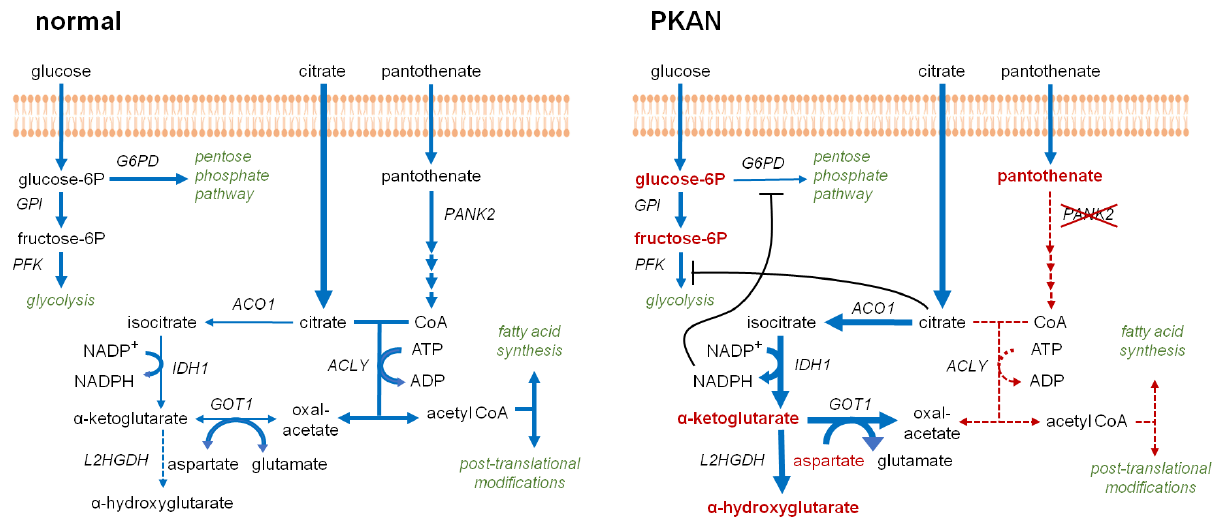
Figure 6. Pathway model of a potential citrate shunt in PKAN erythrocytes. In erythrocytes, citrate imported from the plasma is the only source for the acetyl moiety in acetyl-CoA, which is the primary building block for fatty acid synthesis and essential for post-translational modifications. Its formation is mediated by ACLY under consumption of ATP and citrate. Depletion of CoA largely impairs this reaction in PKAN erythrocytes. An alternative citrate pathway via ACO1 and IDH1 is preferably active in PKAN erythrocytes since metabolites of this route were found to be altered accordingly. Metabolites with normal abundances are in black, pathways are in italic green font. Altered metabolites are shown in red, normal font indicates decreased and bold fonts increased levels. Pathways that are strongly affected in PKAN erythrocytes are indicated with dotted lines and arrow heads in red. The red cross indicates absent/inactive PANK2 protein due to the genetic condition. Black arcs indicate potential inhibition of G6PD by elevated NADPH/NADP + ratios and of PFK by increased citrate and ATP levels. The following enzyme acronyms are used: aconitate hydratase (ACO1), isocitrate dehydrogenase (IDH1), aspartate-aminotransferase (GOT1), ATP-citrate synthase (ACLY), α -hydroxyglutarate dehydrogenase (L2HGDH), glucose-6-phosphate isomerase (GPI), glucose-6-phosphate dehydrogenase (G6PD), phosphofructokinase (PFK), and pantothenate kinase 2 (PANK2).